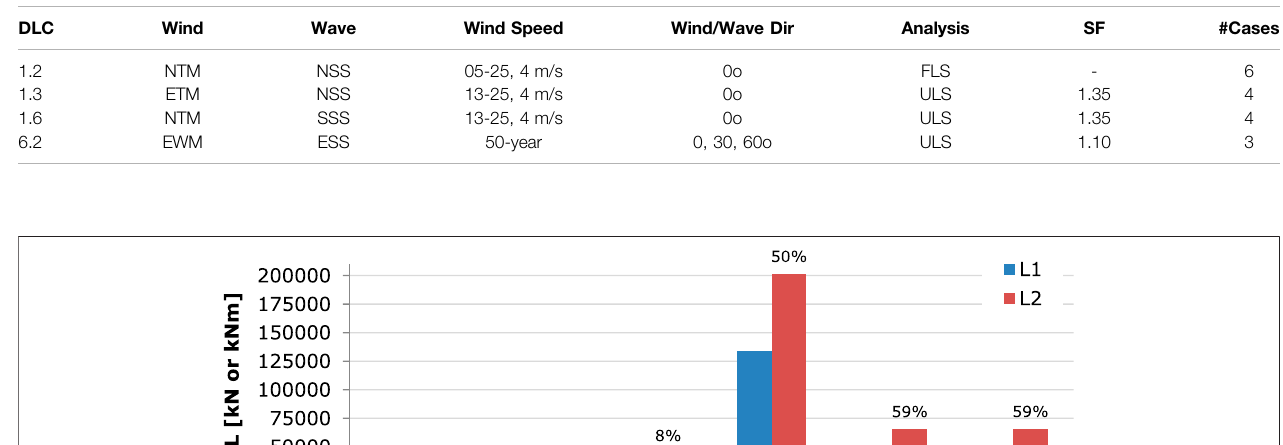
TABLE 4 | De fi nition of DLCs for time domain calculations.